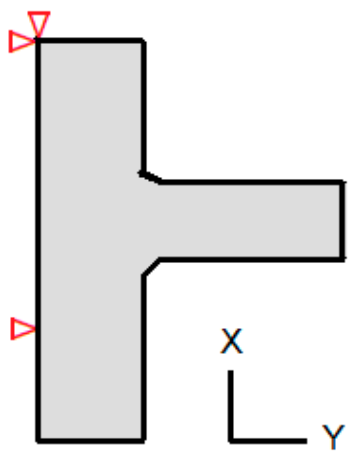
Figure 4. Mechanical boundary conditions. Figure 4 . Mechanical boundary conditions.